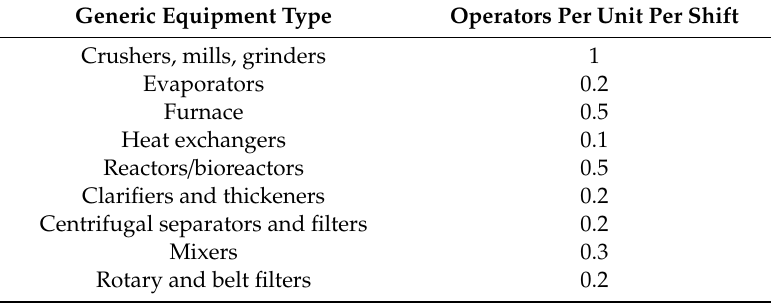
Table 2. Assumptions for operator requirements for various types of process equipment